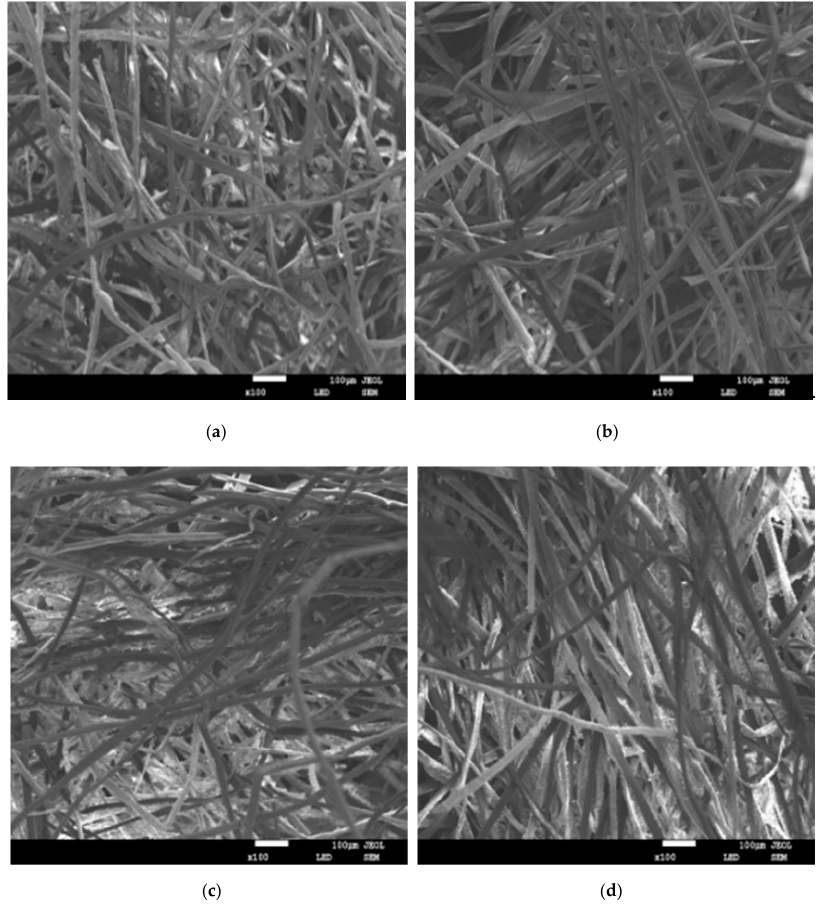
Figure 7. Scanning electron microscope (SEM) images of composites with different mass fractions of kapok fiber. ( a ) Mass fraction of kapok fiber of 30% ( b ) Mass fraction of kapok fiber of 40%. ( c ) Mass fraction of kapok fiber of 50% ( d ) Mass fraction of kapok fiber of 60%.